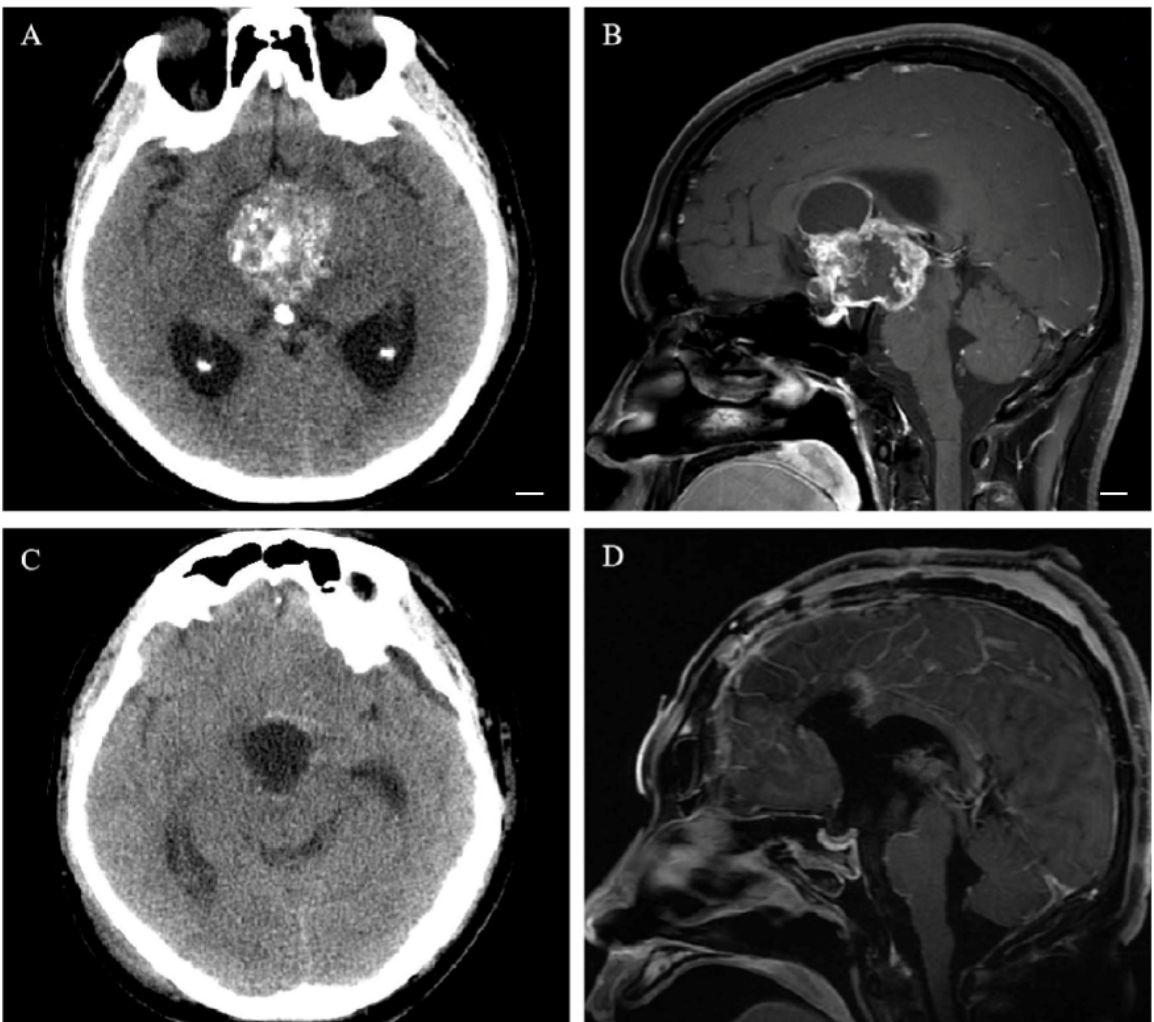
Figure 2. A 35-year-old male with apathy for 2 years accompanied by vision loss for 1 month pre- sented with preoperative panhypopituitarism. CT MRI showed a solid-cystic space-occupying lesion with calcification in suprasellar, the third ventricle and the lateral ventricle ( A , B ). The hypo- thalamus was involved in the tumor (Puget grade 2). The pituitary stalk was invaded and encased by the tumor and was removed during surgery. The tumor and calcification were completely re- sected ( C , D ), and the patient developed panhypopituitarism and diabetes insipidus after surgery. Scale bar: 1 cm.